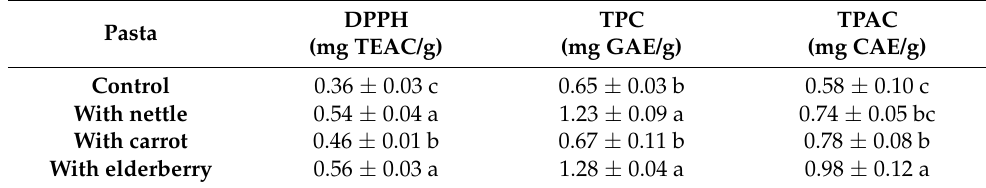
Table 3. Antioxidant profile of evaluated